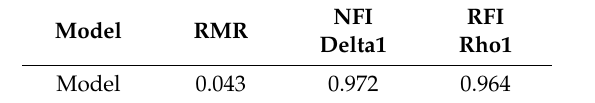
Table 4. Indicators of overall model fit for the unweighted least squares (ULS) measurement model.